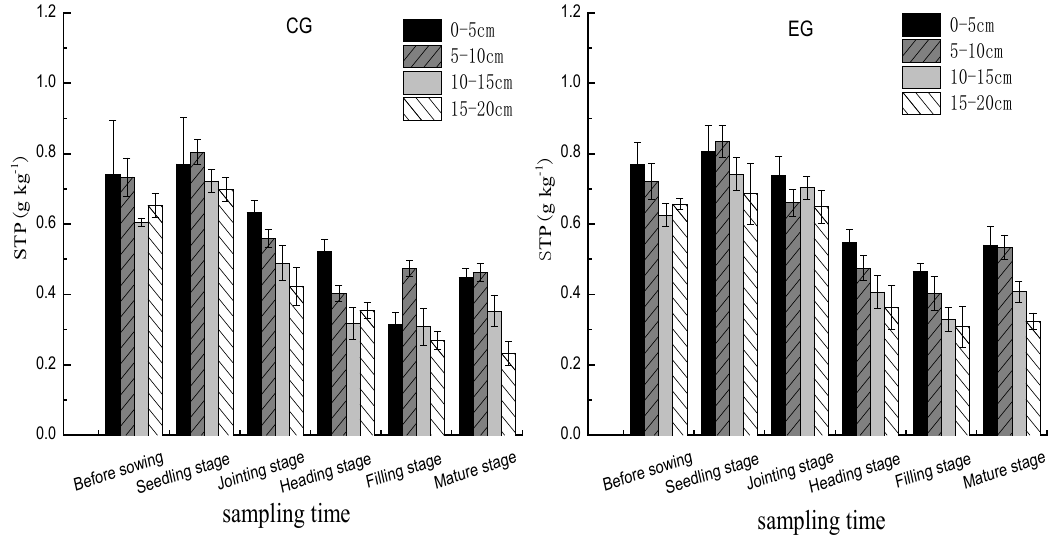
Figure 2: STP concentrations in the control group (CG) and the experimental group (EG) soils subject to poultry wastewater irrigation.